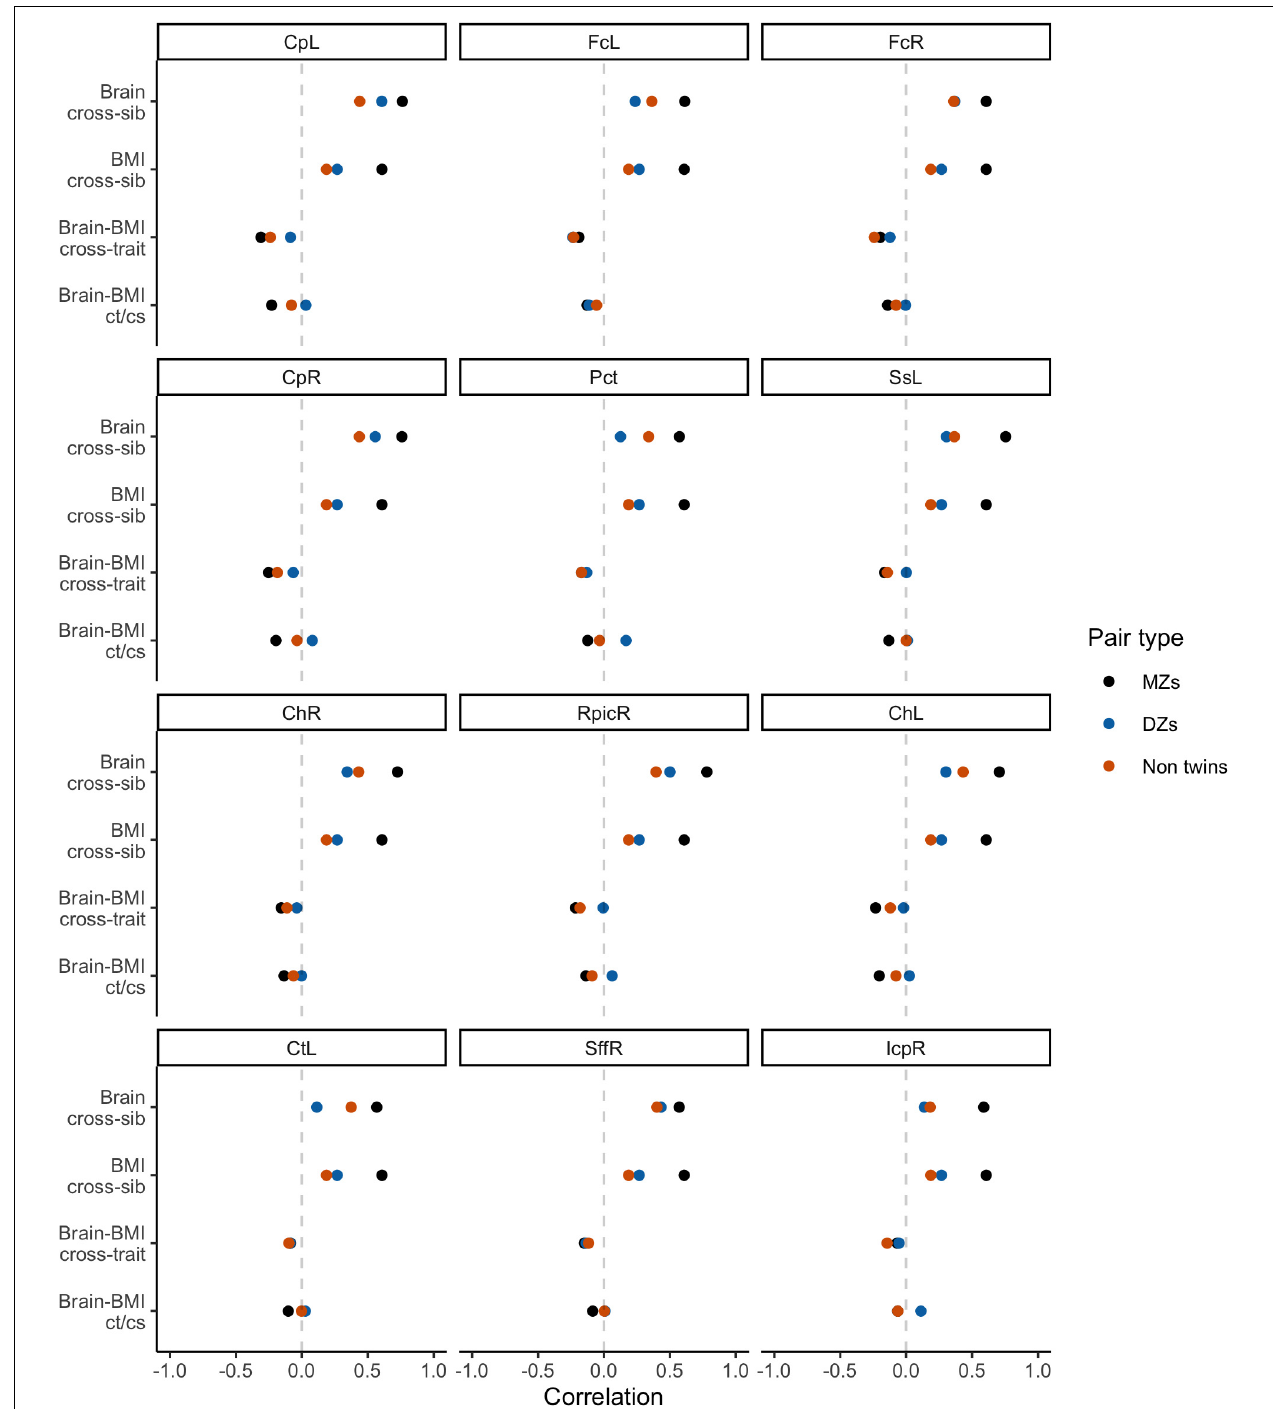
FIGURE 4 | Phenotypic correlations across siblings and across traits.